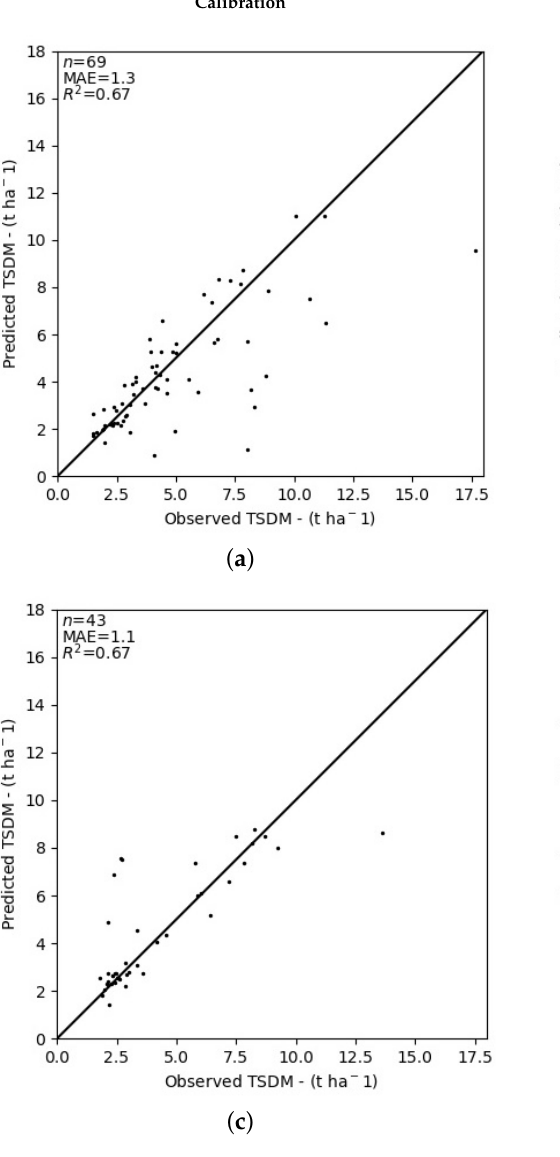
Figure 11. Least squares linear relationship between RPAS-estimated biomass and Planet Dove satellite image data-predicted biomass at peak growth for both the short grassland ( a , b ) and short woodland ( c , d ) pasture models.